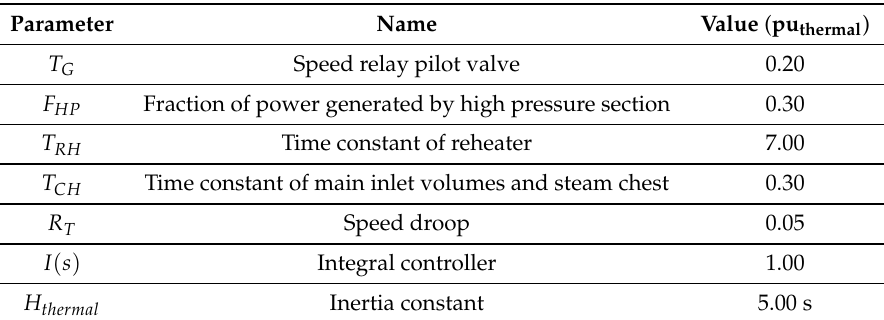
Table A1. Thermal power plant parameters